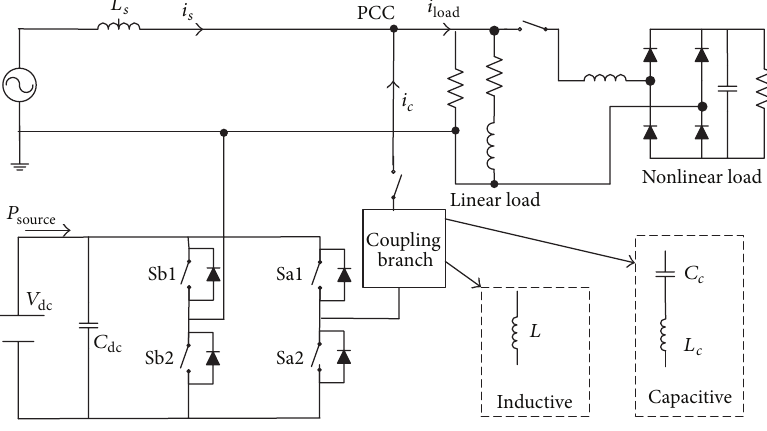
Figure 7: Simulation models.